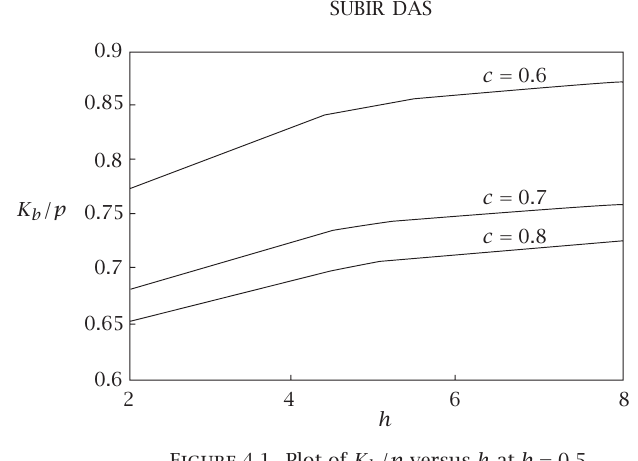
b /p versus h at b